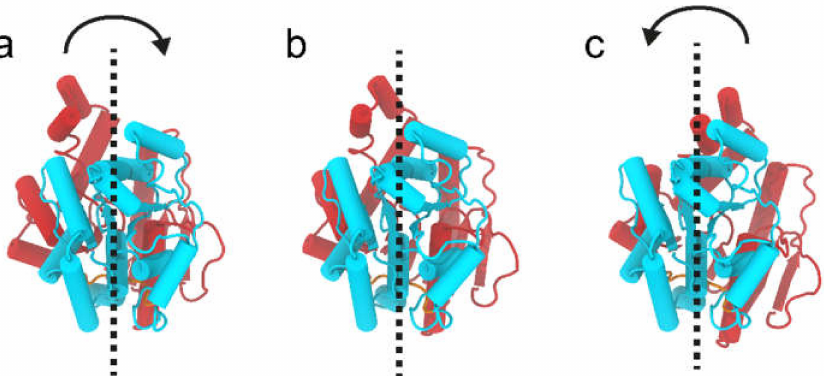
Figure 12. Graphical representation of the twist-like dynamics of WaaG. The C-domain of the protein (in cyan) is kept aligned, while the rest of the protein moves. Depicted are the two extremes ( a , c ) of the twist-like movements of the N-domain (in brick-red color) with respect to the C-domain and a representation of the two domains when aligned in the eclipsed state ( b